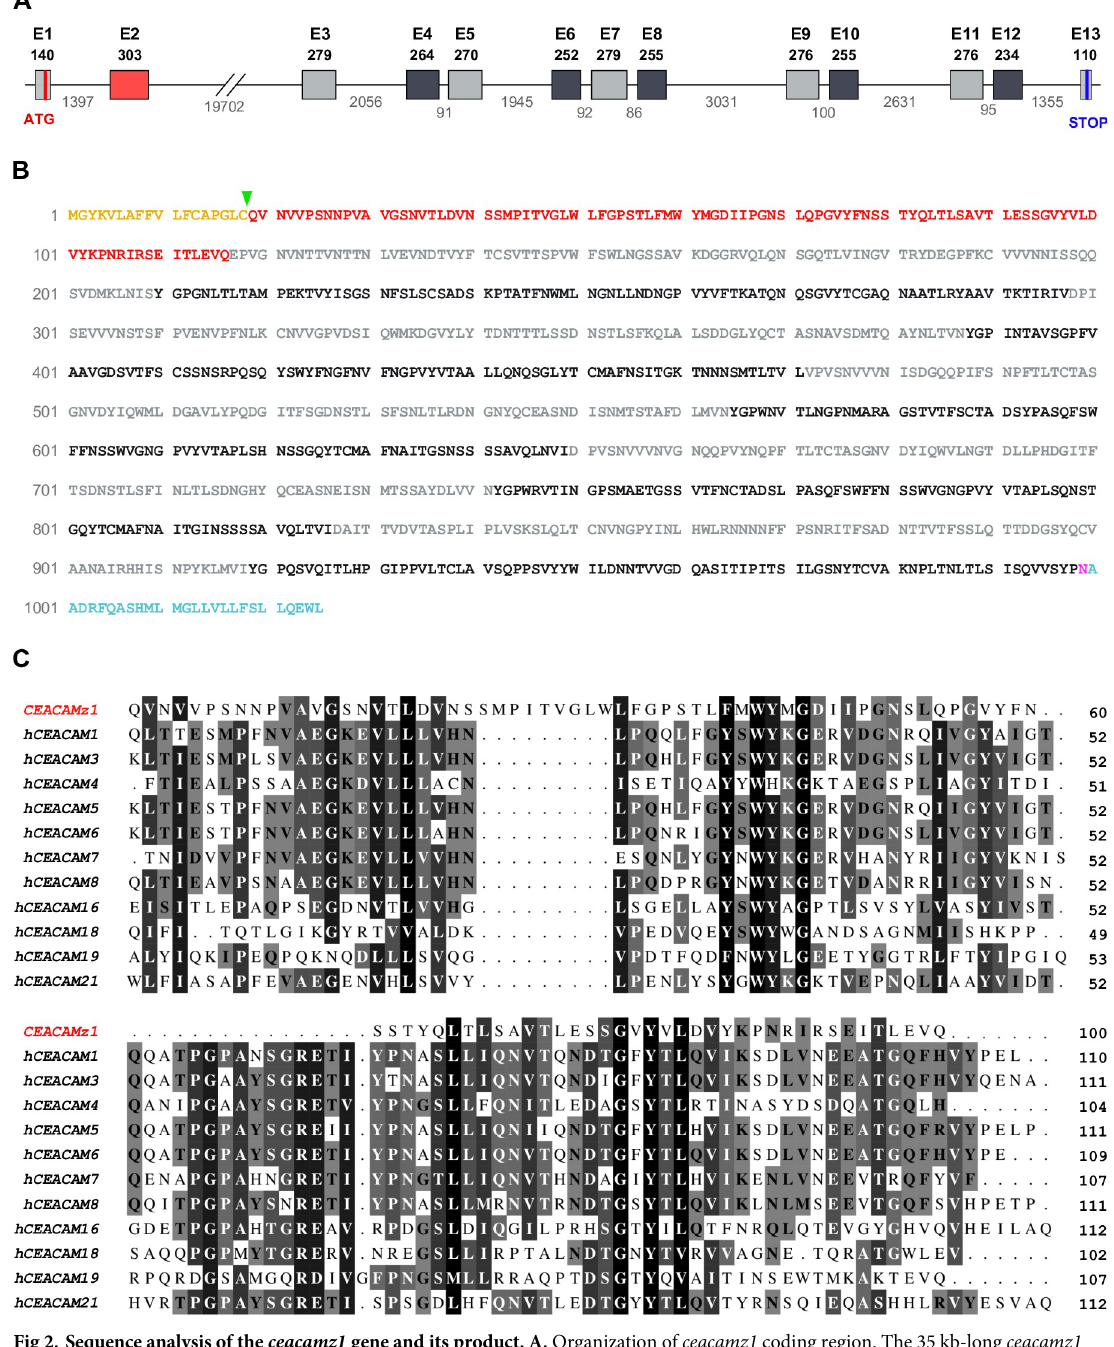
PLOS ONE | https://doi.org/10.1371/journal.pone.0254533 July 12,